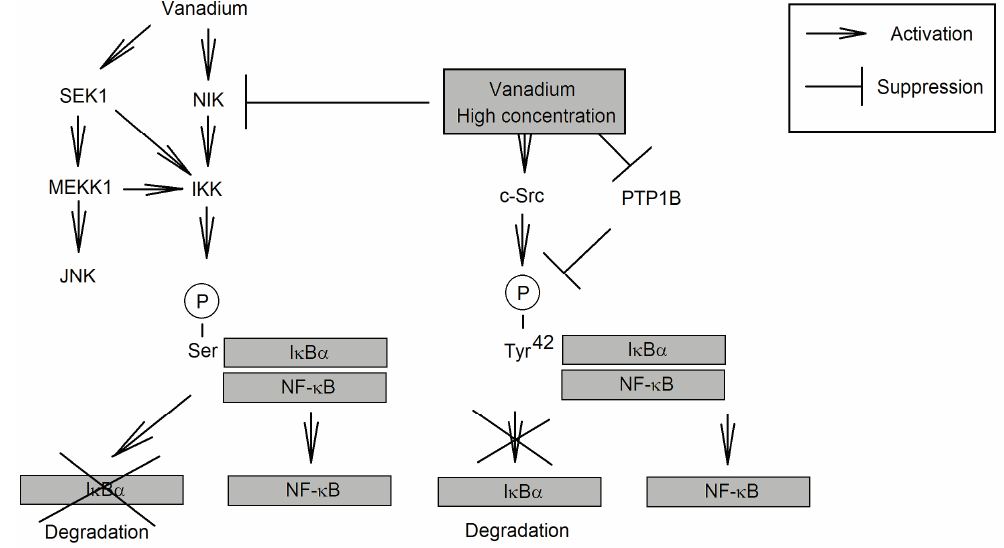
Figure 5. The mechanism of activation of NF- κ B by vanadium compounds. Vanadium compounds at low concentrations activate NF- κ B via NIK. This results in the degradation of I κ B α and the release of NF- κ B. The activation of IKK by vanadium compounds may also involve kinases from the JNK MAPK cascade. At high concentrations vanadium compounds have a different mechanism of NF-KB activation. They inhibit the activity of NIK and cause I κ B α phosphorylation at Tyr 42 , which triggers the release of NF- κ B but inhibits the proteolytic degradation of I κ B α